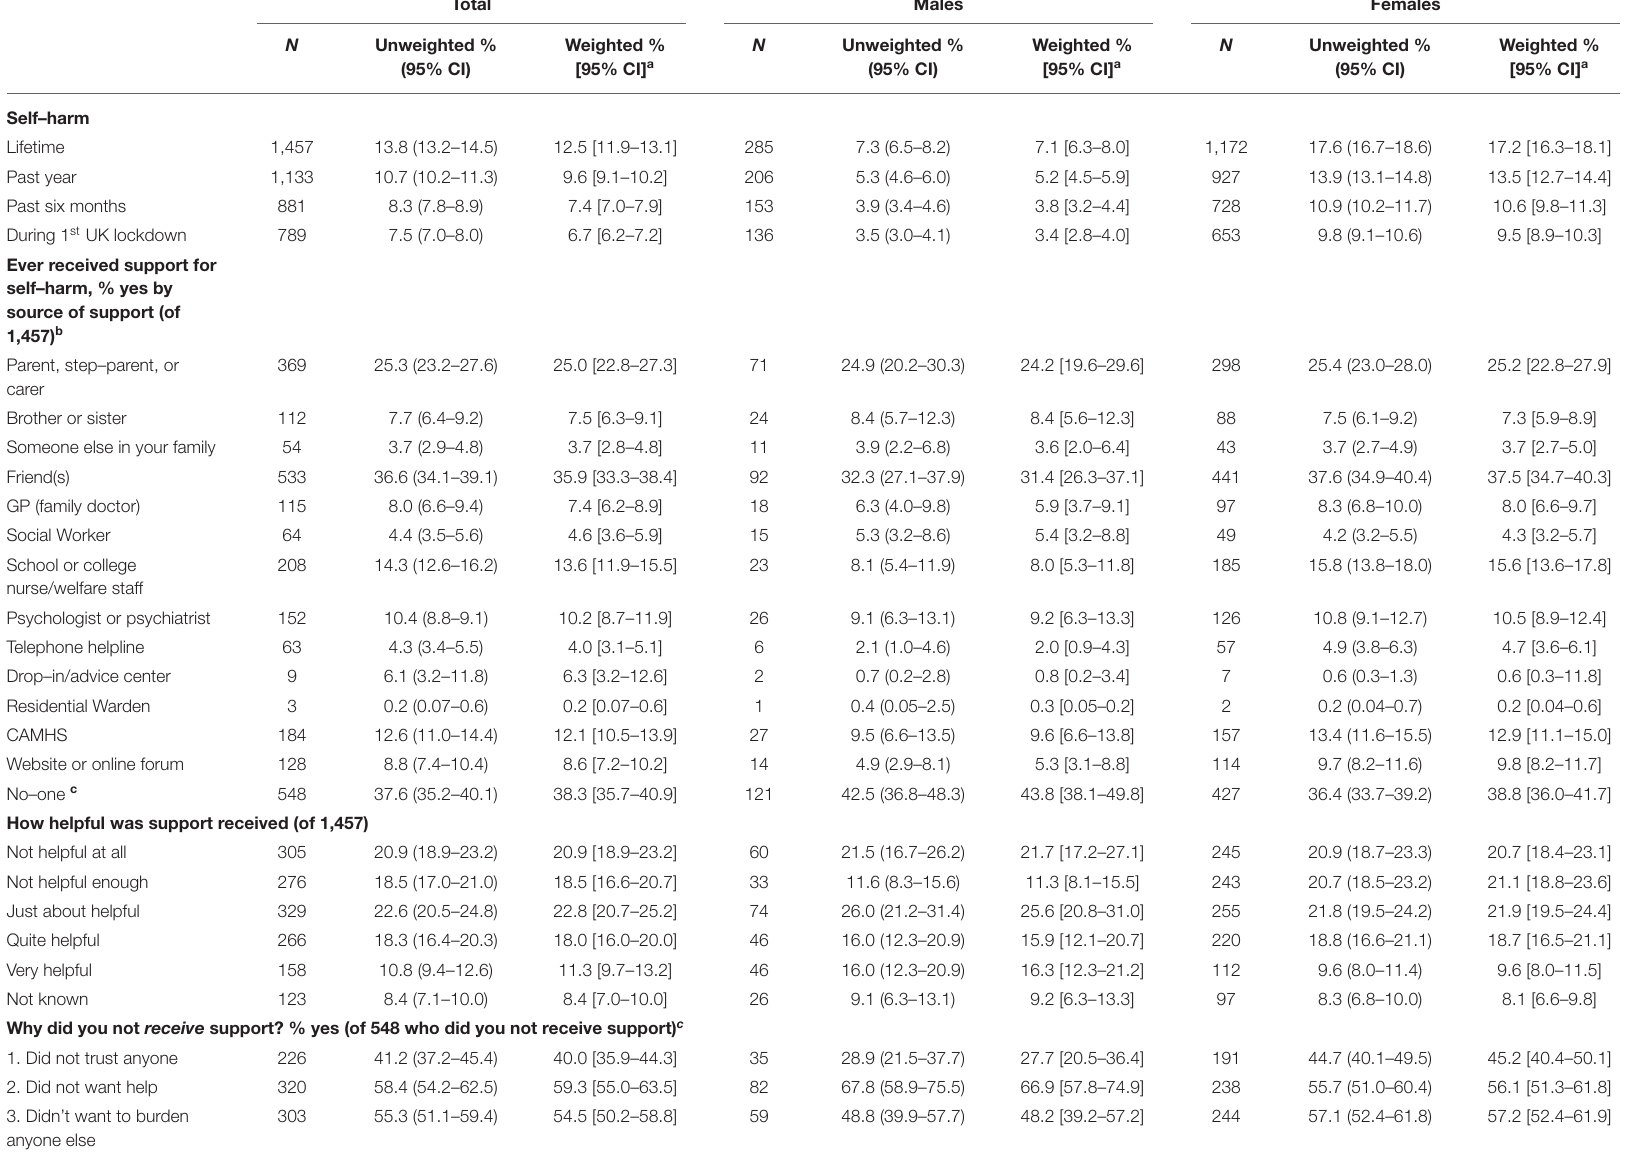
TABLE 2 | Prevalence of self–harm and care received, unadjusted and weighted proportions with 95% confidence intervals, by gender. Total Males